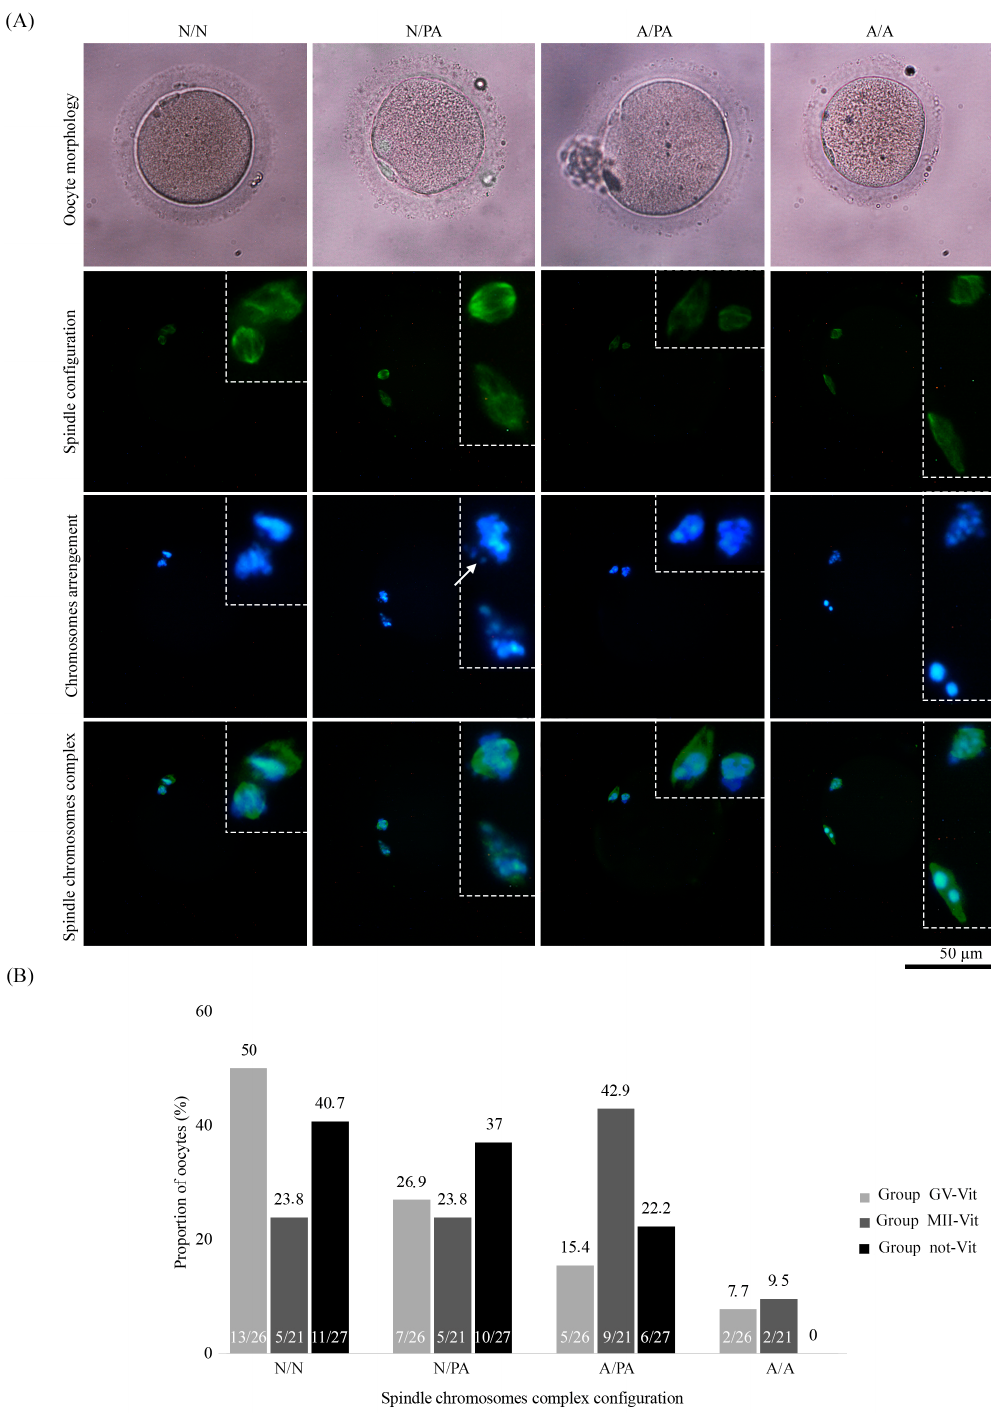
Figure 3 . Oocyte categories according to the whole spindle chromosomes complex configuration. N/N: Polymerized spindle and normal chromosome distribution; N/PA: Polymerized spindle and partially abnormal chromosome distribution; A/PA: Depolymerized spindle and partially abnormal chromosome distribution; A/A: Depolymerized spindle and abnormal chromosome distribution. ( A ) Oocyte morphology by bright field microscopy and confocal micrographs of spindle chromosomes complexes. Anti- α / β -tubulin antibody and Alexa Fluor 488 to visualize the spindle configuration (green) and DAPI to stain the chromosomes arrangement (blue). Chromosomes slightly displaced from the plane of the metaphase plate (write arrow). In the dotted box, the mitotic spindle and chromosomes were amplified for easy viewing. ( B ) Proportion of oocytes according to their Spindle chromosomes complex configuration in the three groups of study (Group GV-Vit, Group MII-Vit, and Group not-Vit), p -value > 0.05. This graph also contains, inside the bar, information on the number of oocytes included in each